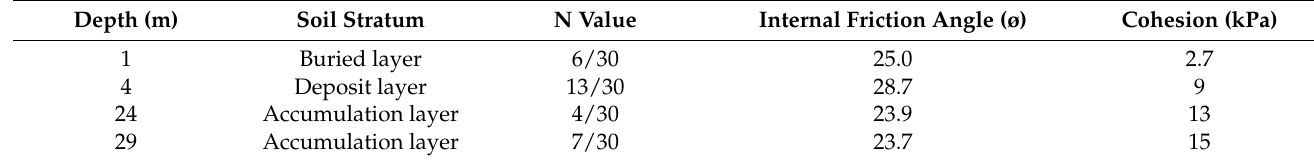
Table 2. Result of borehole shear and consolidated undrained test.